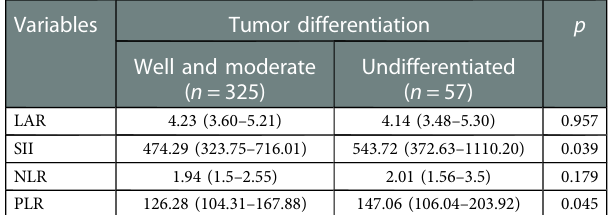
TABLE 3 Correlation between immune-in fl ammatory biomarkers (IIBs) and tumor differentiation in all CRC patients. Variables Tumor differentiation p Well and